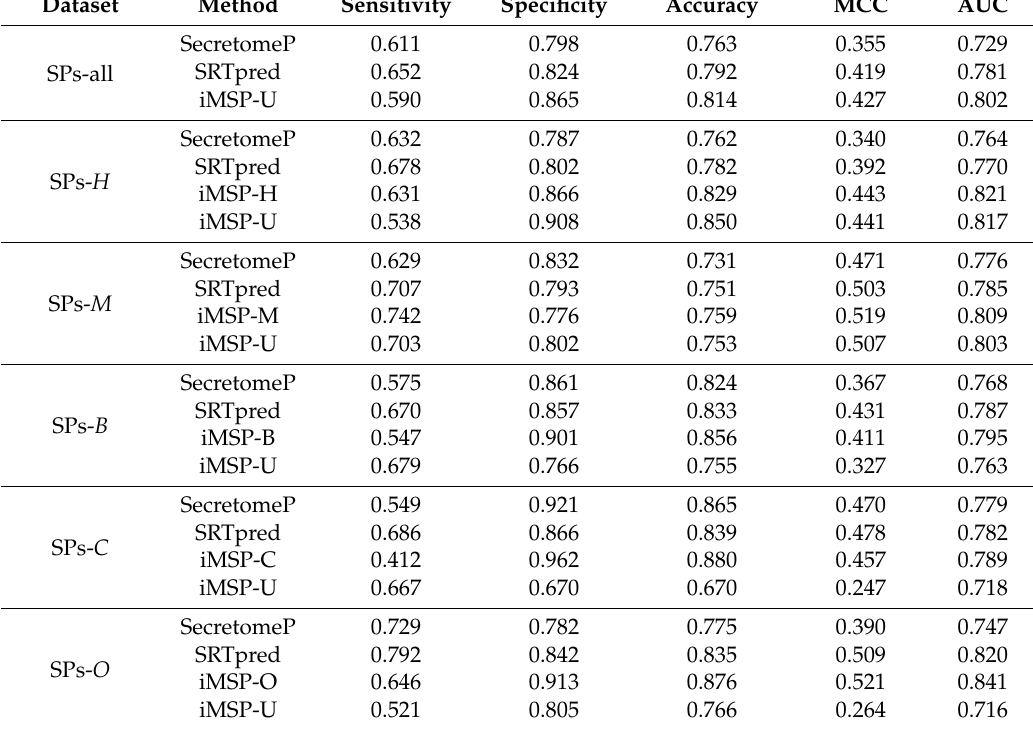
Table 5. The performance of different methods on six testing